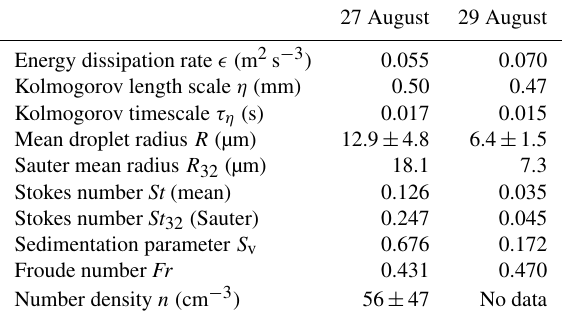
Table 1. Properties of turbulence and cloud droplets during obser- vation